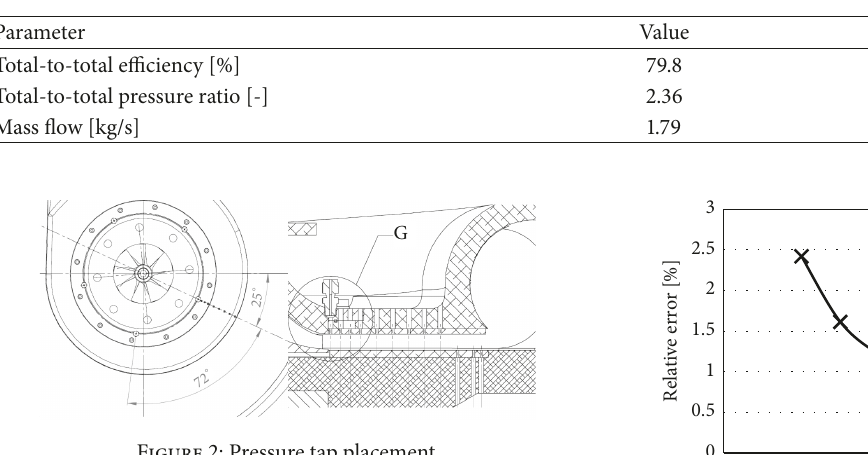
Table 2: Design operating point performance.